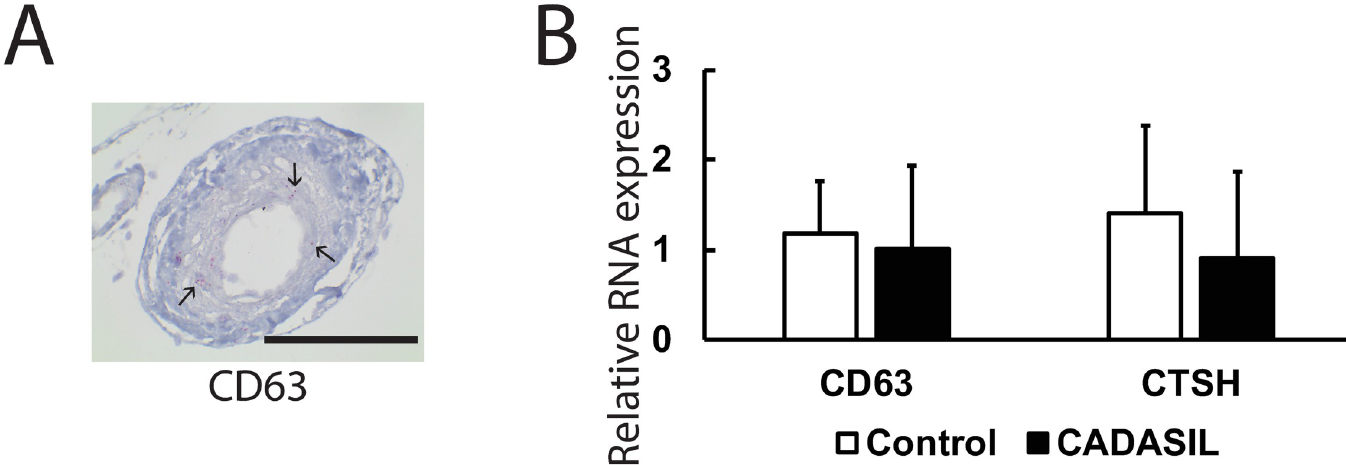
Fig 9. In situ mRNA localization and levels of expression of non-myocyte factors, CD63 and CTSH, in CADASIL arteries. (A) Representative artery which display clear CD63 mRNA signal in the media of leptomeningeal arteries by in situ hybridization. Similar findings were obtained with multiple vessels in several patients. Arrows point to the pink signal of mRNA molecule in vascular smooth muscle layer of arteries. Scale bar shows 100 microns. (B) Quantitative RT-PCR was performed for CD63 and CTSH to assess relative expression of corresponding mRNA in CADASIL and control frontal brain samples.